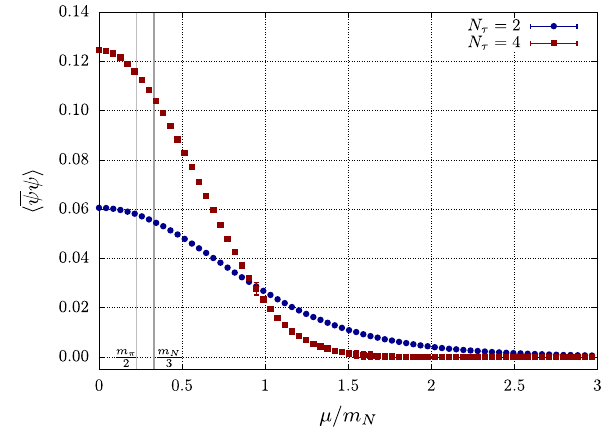
Fig. 15 The chiral condensate as a function of the chemical potential, in units of the nucleon mass, for different temperatures. Also indicated are the lines of pion (left) and baryon (right)